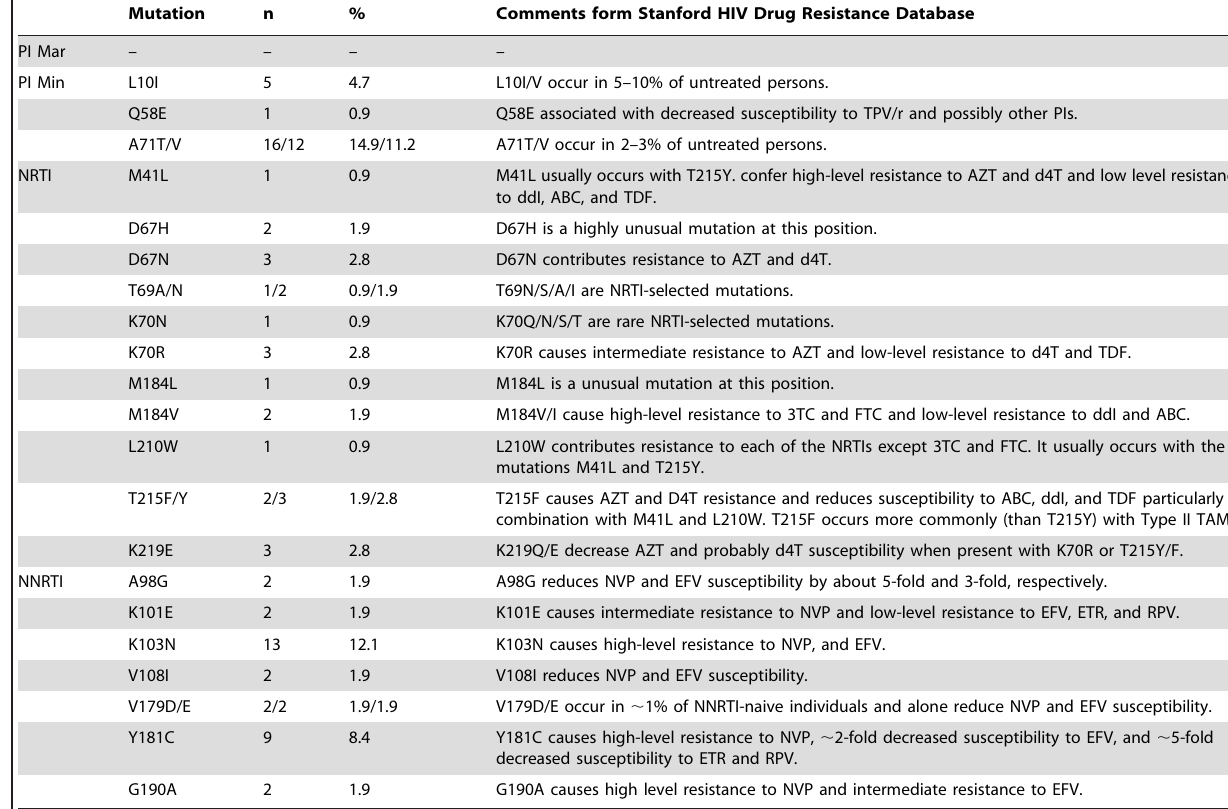
Table 4. Resistance loci feature comments.